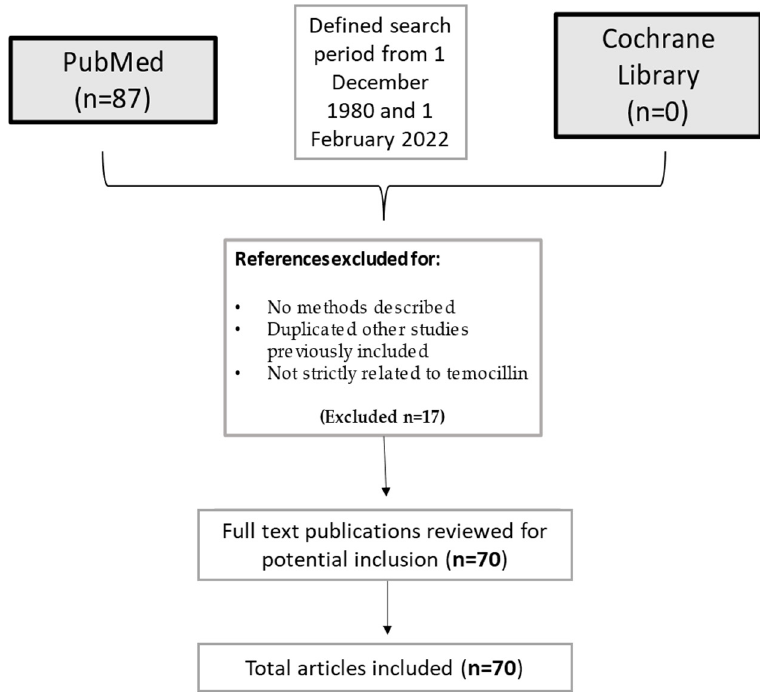
Figure 3. Flow-chart of the studies considered in the narrative review .